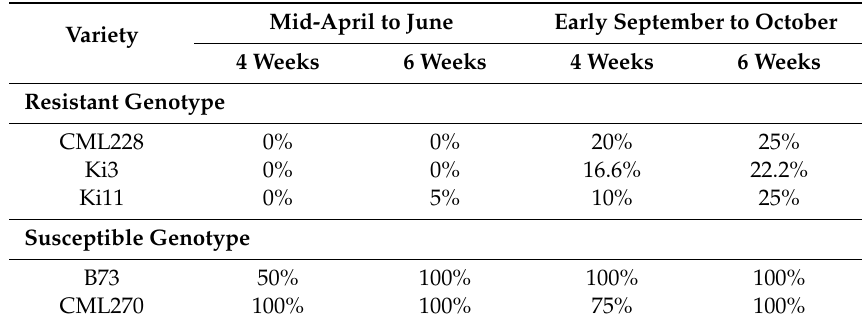
Table 1. Downy mildew (DM) Incidence of resistant (CML228, Ki3, and Ki11) and susceptible (B73, and CML270) parents in Phnom Penh, Cambodia 2015.